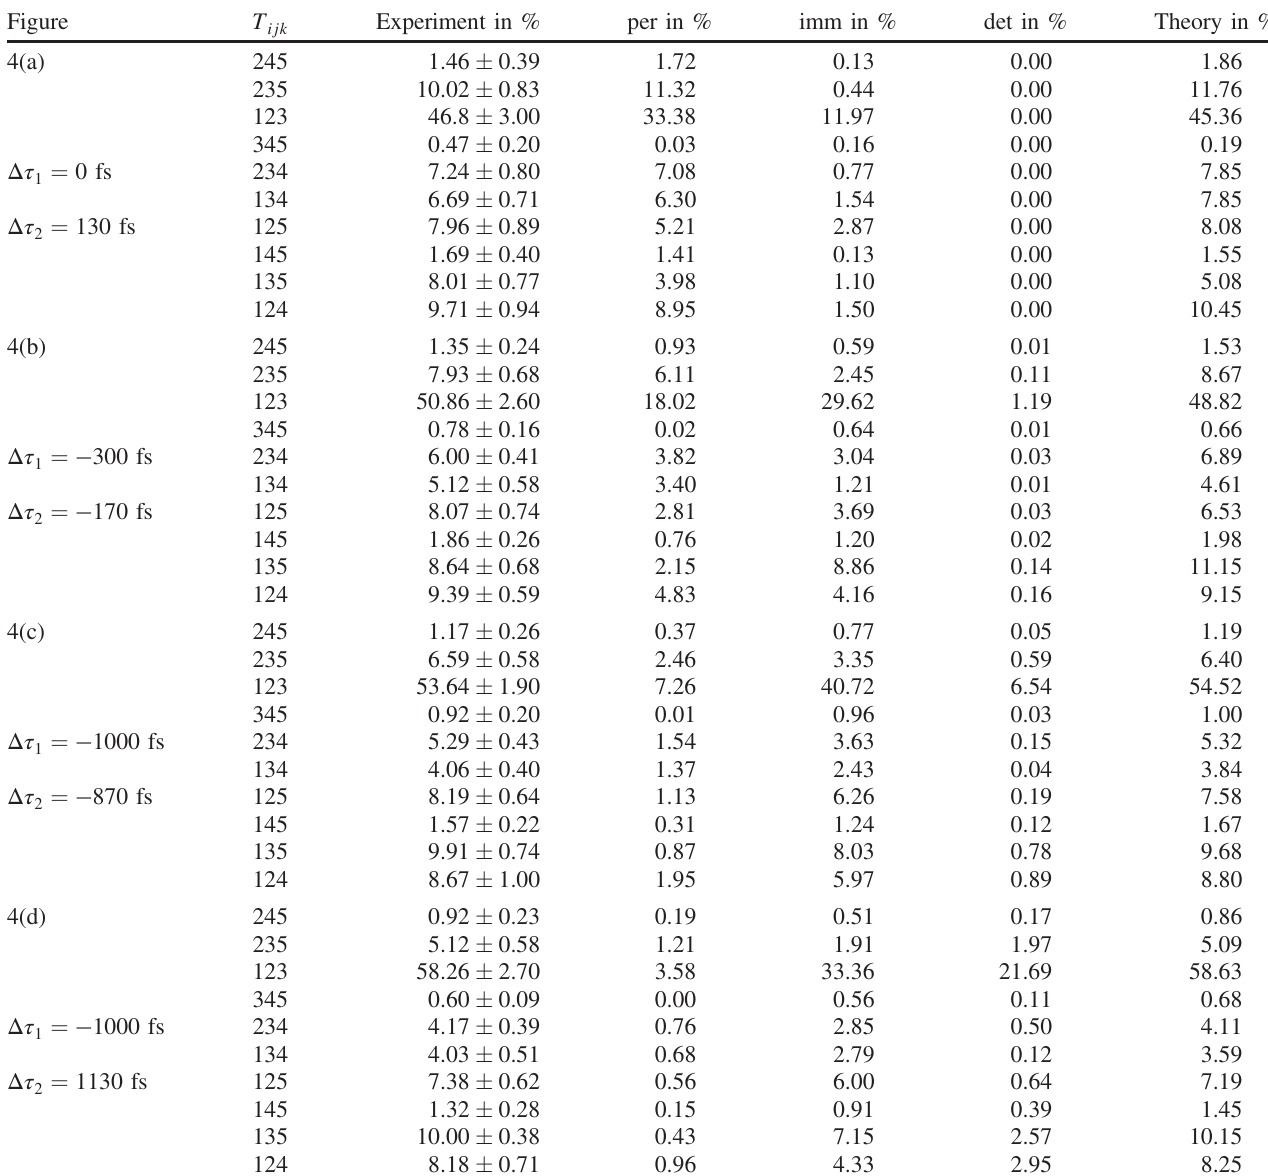
TABLE IV. Data for the normalized output probability distributions of Fig. 4. The column “ Figure ” specifies the temporal delays of ” refers to the scattering submatrix of Eq. (A12). The experimentally acquired count rates each part of Fig. 4, whereas the column “ T ijk are normalized to unit vectors, then fitted to the theoretical output probability and given under column “ Experiment in %. ” The errors are standard deviations over 19 independent measurements. The last column, “ Theory in %, ” shows the theoretical output probability according to Eq. (A16). The contribution of the permanent, the immanant, and the determinant to this theoretical value is given in the columns “ per in %, ” … imm in %, ” and “ det in %, ”